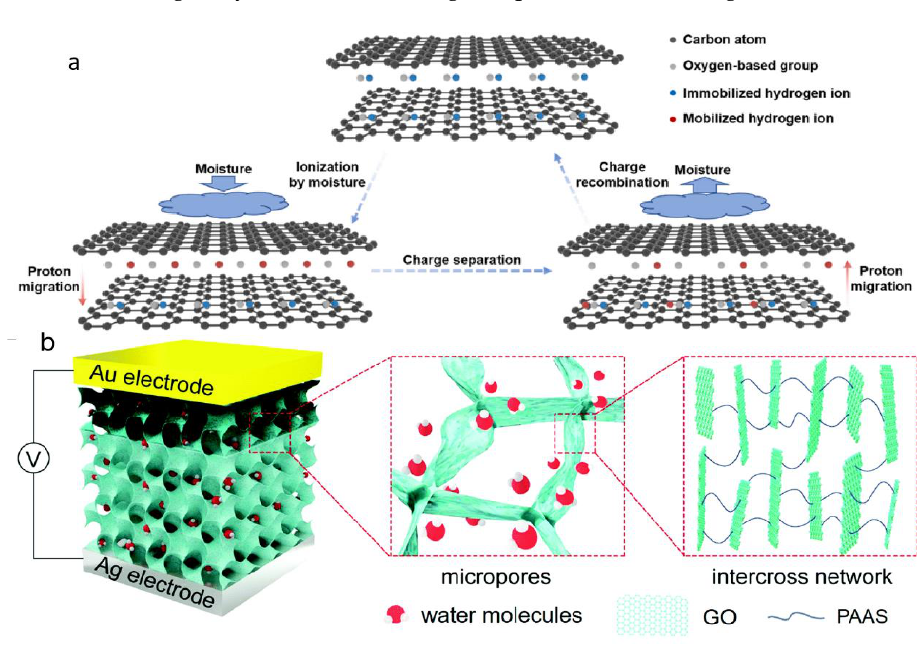
Figure 7. ( a ) Electric generation for acidified GO/PVA film. The protons in the functional groups of GO are mobilized by moisture absorption and achieve charge separation by proton migration toward the inner layer. Conversely, the migration direction is opposite under the moisture removal and contributes to the charge recombination. Reprinted with permission from Ref. [83]. Copyright 2022 American Association for Nano Energy; ( b ) Schematics of MEG. The MEG is composed of a pair of metal electrodes and porous GO composite with absorbed water molecules and heterogeneous chemical structure, where the darkened upside area was reduced by a directionally controlled laser. The GO composite has substantial micropores facilitating water molecule absorption and an abundant cross-linking network providing ion channels for fast carrier migration. Reprinted with permission from Ref. [84]. Copyright 2019 American Association for Energy&Environmental Science.